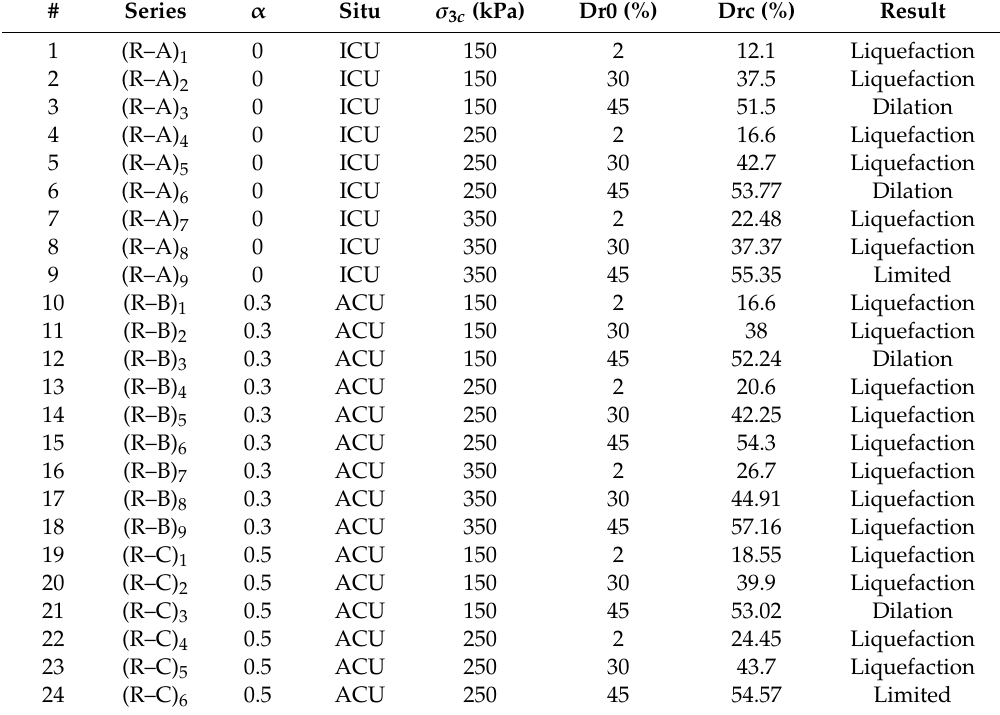
Figure 7. Steady state line in q–p’ plane with all 27 stress paths.